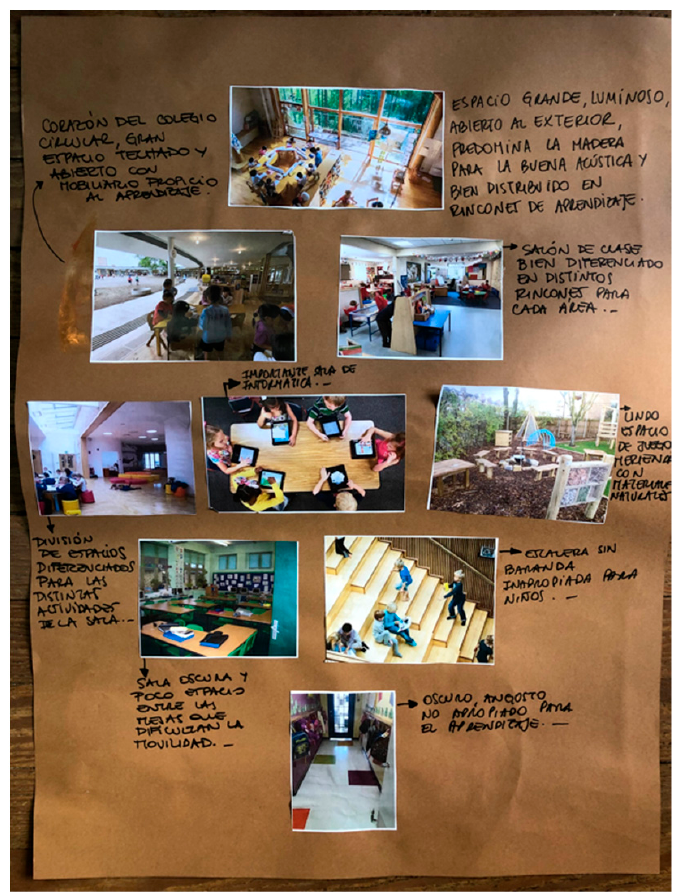
Figure 6. An example of the result of a diamond ranking exercise.